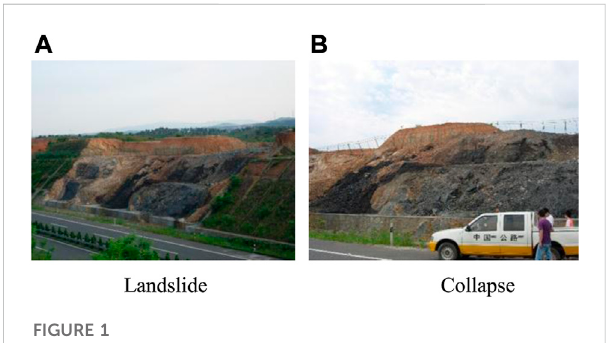
FIGURE 1 Landslide and collapse of coal measure slope on Beijing – Hong Kong & Macao Expressway. (A) Landslide (B) Collapse.